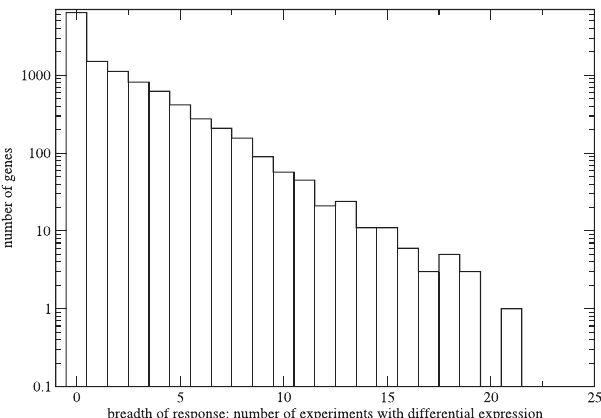
Figure 1. Semilogarithmic Frequency Distribution of the Number of Different Experiments in which Genes Were Found to Be Differentially Expressed Defined Here as the Breadth of Differential Gene Expression Response